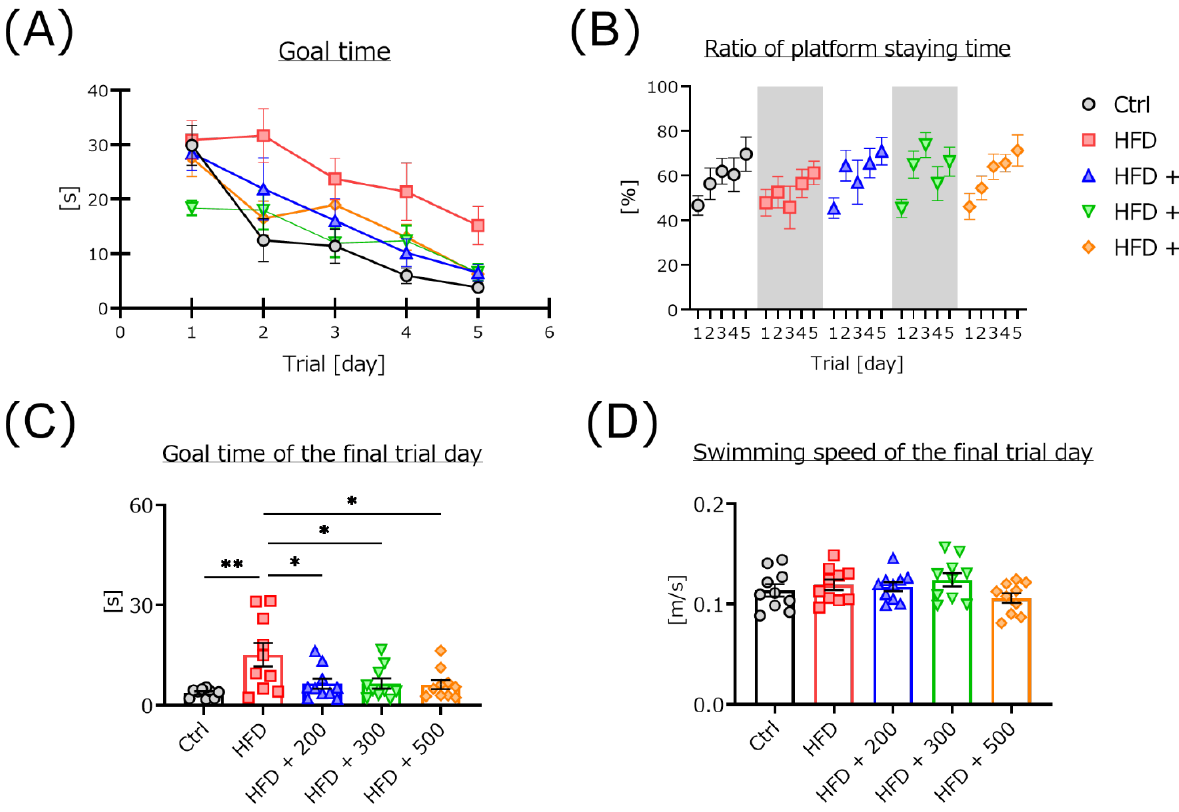
Figure 1. Differences in cognitive function between control, HFD-treated, and HFD plus DSW-extract-added water-treated mice. The time to goal (escape latency) in the Morris water maze test is shown in panel ( A ). The ratio of staying time in the platform quadrant is shown in panel ( B ). The average goal times of the final trial day are shown in panel ( C ). The average swimming speed on the final trial day is shown in panel ( D ). Control (Ctrl, n = 10), high-fat diet (HFD, n = 10), HFD + DSW-extract-added water hardness 200 (HFD + 200, n = 10), HFD + DSW-extract-added water hardness 300 (HFD + 300, n = 10), HFD + DSW-extract-added water hardness 500 (HFD + 500, n = 10). * p < 0.05, ** p < 0.01. The data are shown as means ± SE. Statistical analyses of the goal time were performed using two-way analysis of variance. Statistical analyses of the goal time for each day, swimming speed, and the ratio of staying time in the platform quadrant were performed using the Tukey-Kramer method.